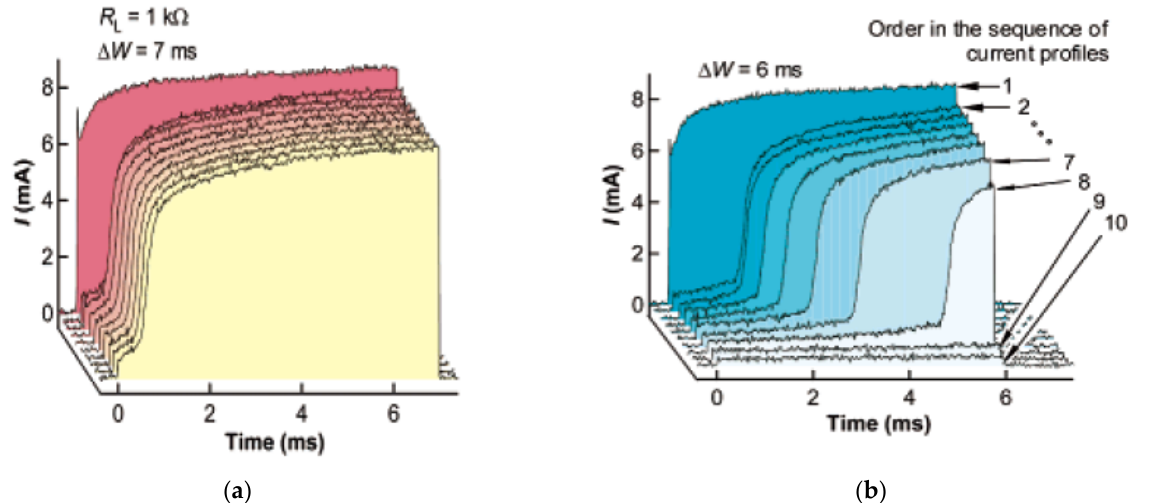
Figure 5. Sequential transient photocurrent measurements under synchronized voltage and photoirradiation pulses using the single crystal of α -(BEDT-TTF) 2 I 3 and a four-probe method at 115 K, where the material is in an insulating phase. Photoirradiation was synchronized only at the first voltage pulse (11 V) and was turned off for the second and following pulses: the voltage pulse widths ( Δ W ) are ( a ) 7 ms and ( b ) 6 ms. Note that Δ W drastically affects the current, i.e., the relaxation time of the highly conducting state (HS) after the cessation of photoirradiation, while Δ W does not affect the resistivity in the HS. Adapted from Ref. [693] with permission.